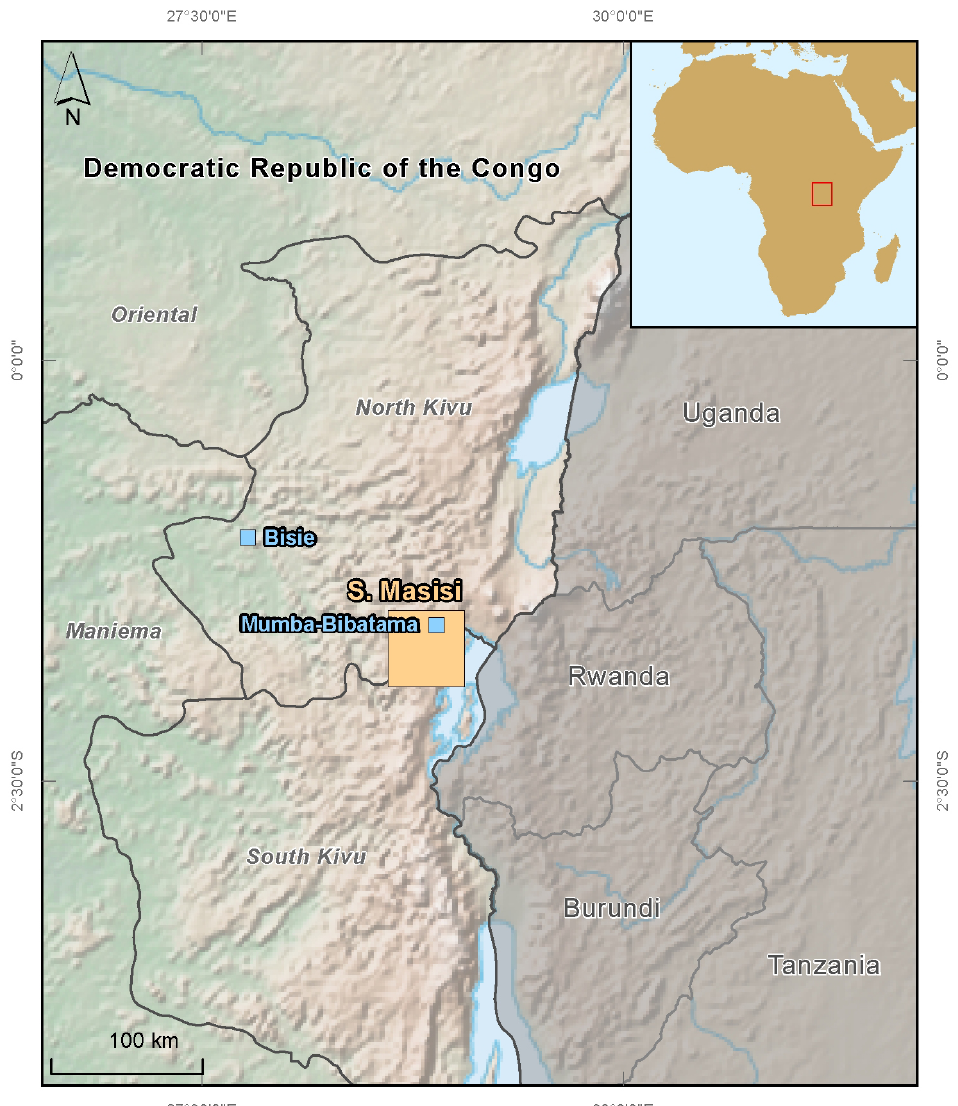
Figure 3. Study areas in North Kivu and South Kivu. Orange: study area for the analysis of HR data; light blue: study areas to be investigated with VHR